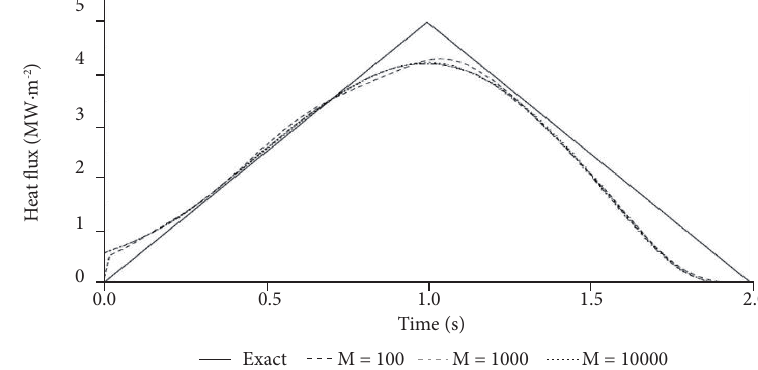
Figure 8. Effect of the quantity of time advances for hypothetic problem with N = 10